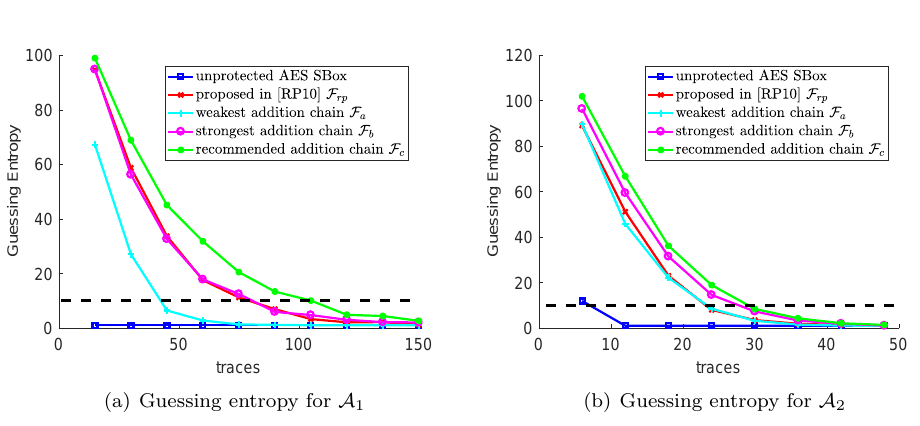
Figure 8: The results of second-order CPA on four different first-order masked addition chain implementations.